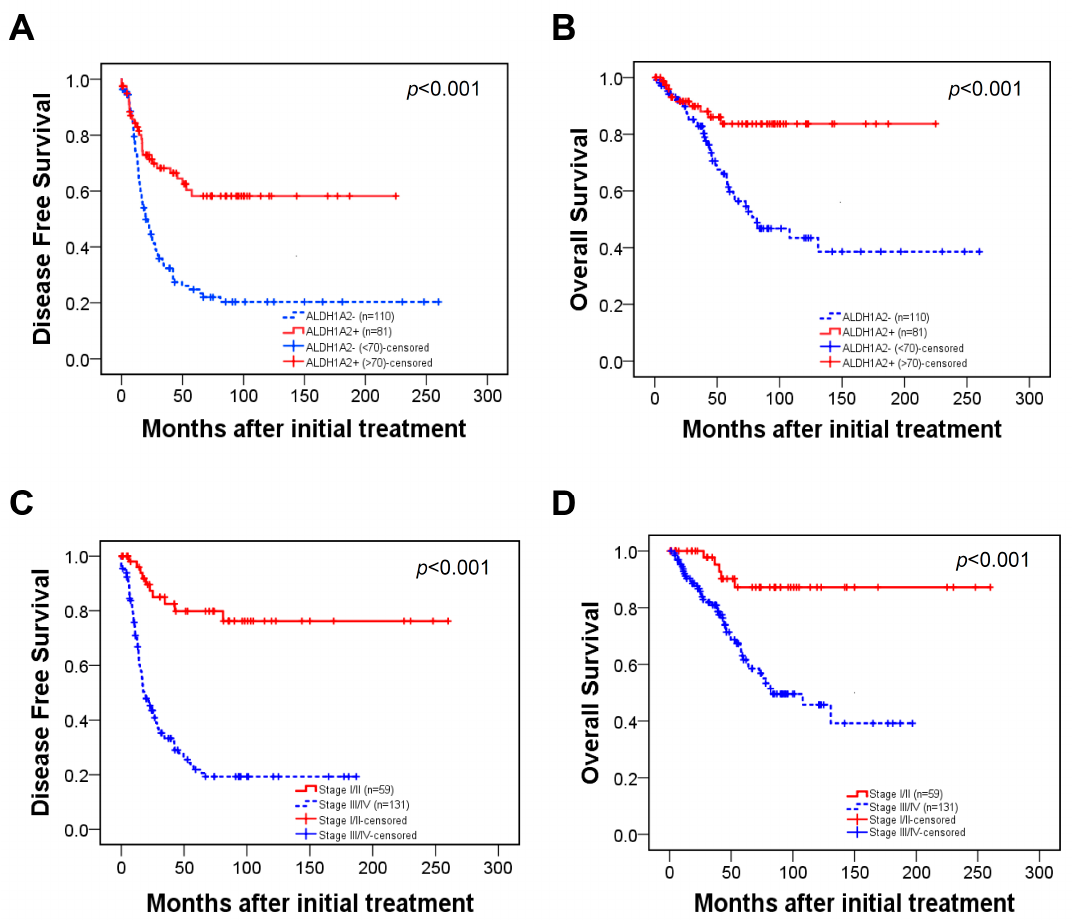
Figure 7. Kaplan–Meier survival curve for patients with epithelial ovarian cancer. ( A , B ) Patients with ALDH1A2 − tumors (histoscore < 70) showed significantly worse disease-free ( A ) and overall survival ( B ) than patients with ALDH1A2 + tumors. ( C,D ) Patients with advanced stages (III / IV) showed significantly worse disease-free ( C ) and overall survival ( D ) than patients with early-stage ovarian cancer.